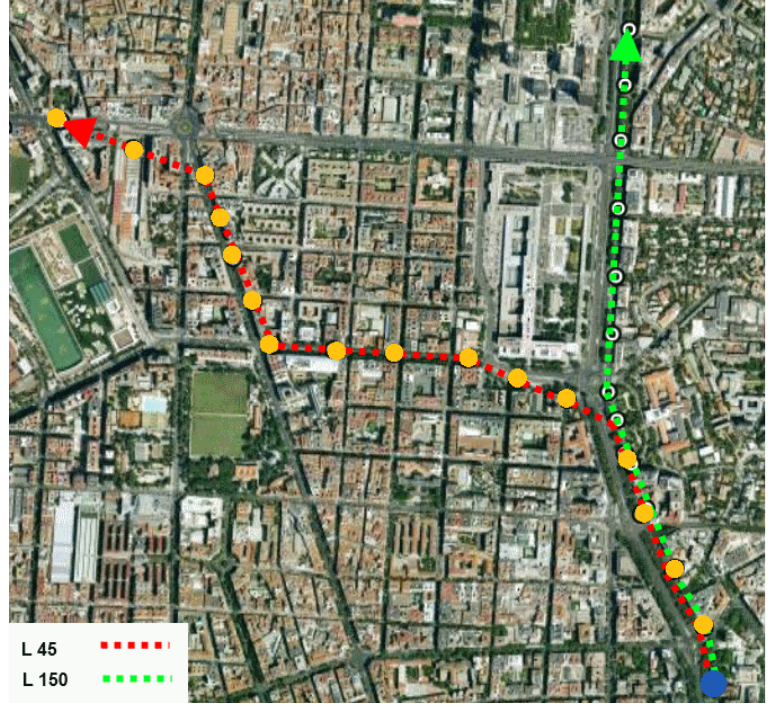
Figure 14. Test scenario. Paths marked in red and green are the bus lines considered. Blue point is the starting location of the user. Yellow dots are the places where the terminal switches from one cell to another and makes the prediction about the next